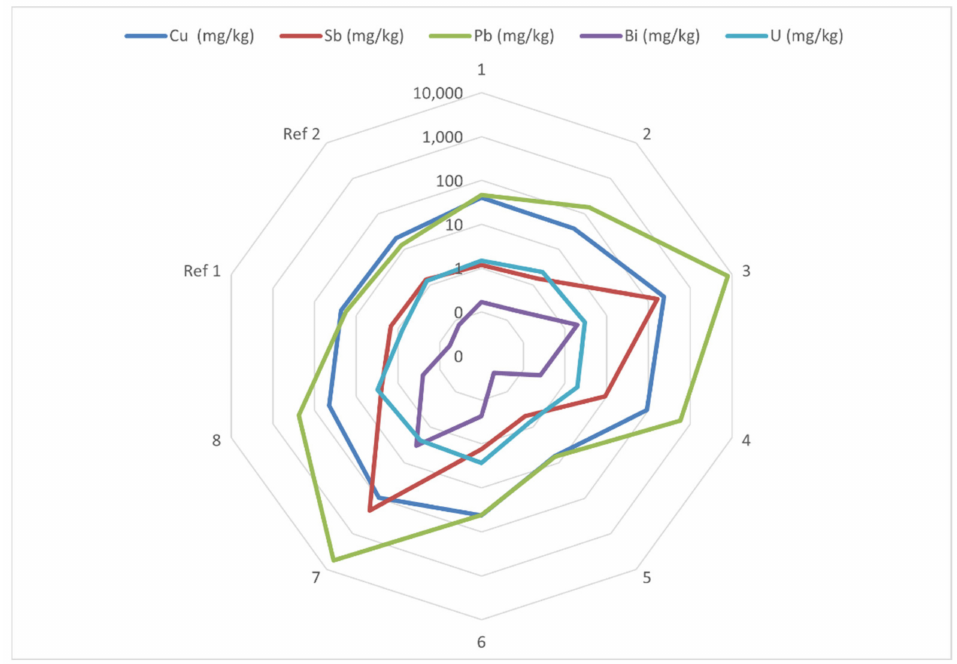
Figure 2. Radar chart showing the concentration (logarithmic scale; N = 7) of copper (Cu), antimony (Sb), lead (Pb), bismuth (Bi), and uranium (U) in surface soil (0–2 cm) and the variation between sampling sites. Dried (120 ◦ C) and sieved (<2 mm) soil was microwave digested at 260 ◦ C using a mixture of nitric (HNO 3 ) and hydrofluoric (HF) acids. See Figure 1 for location of sampling sites 1–8 and reference sites Ref 1 and Ref